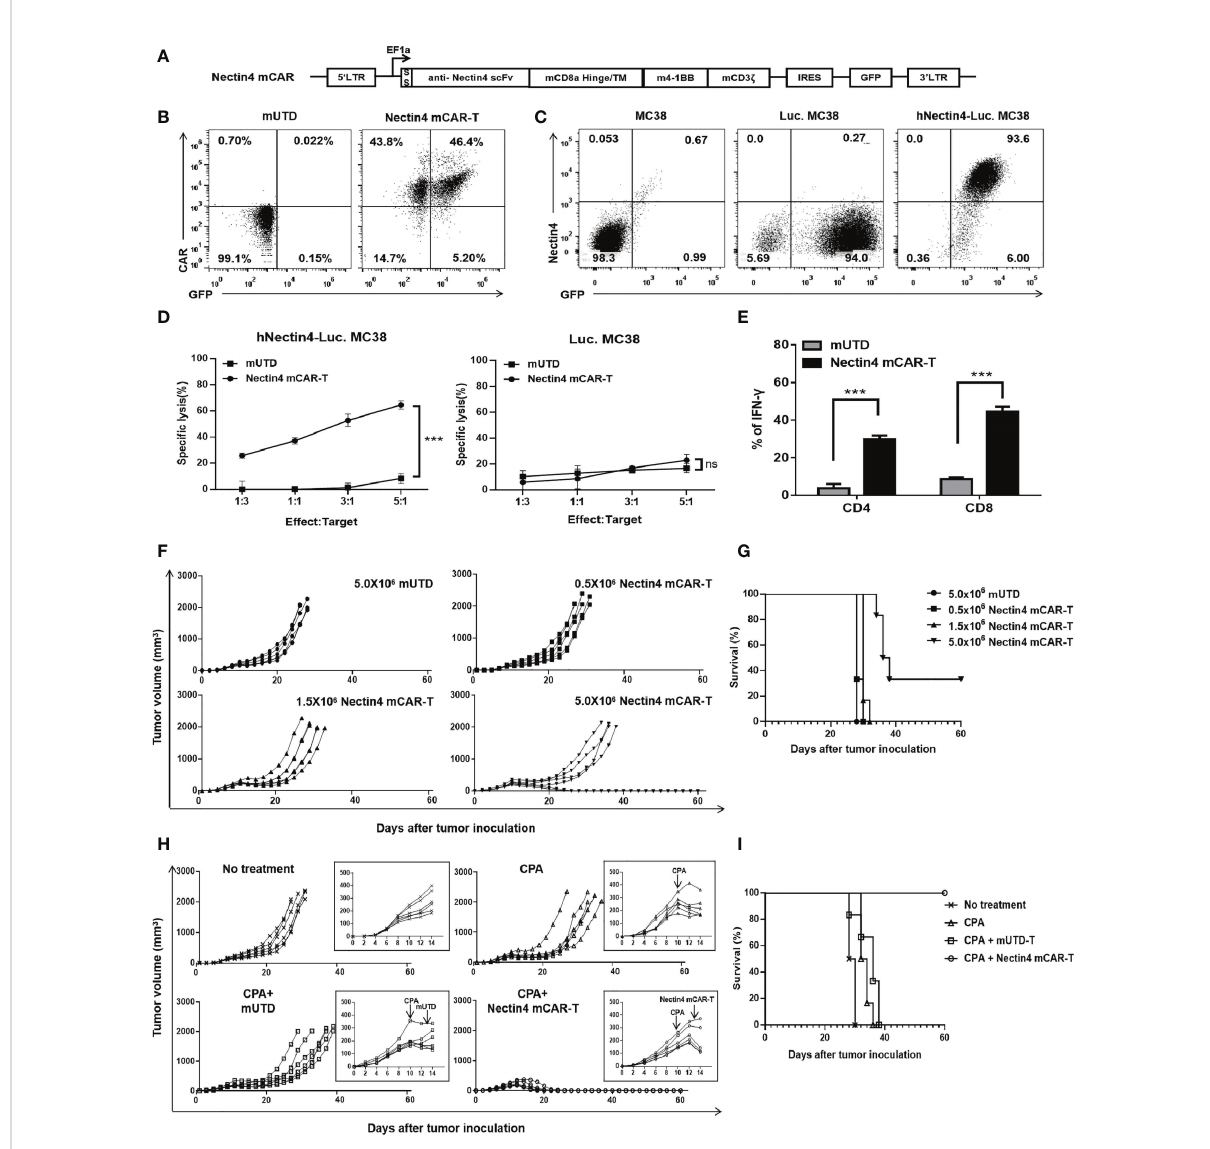
FIGURE 4 Therapeutic effect of Nectin4 mCAR-T cells on metastatic colorectal cancer in fully immune-competent mice. (A) The murine CAR construct was inserted upstream of an IRES-GFP marker in the MSCV retroviral plasmid pMIGR1. (B) mCAR expression of Nectin4 mCAR-T cells transfected with pMIGR1-mCAR-IRES-GFP retroviral particles. mUTD indicates the untransduced mouse T cells. (C) Nectin4 and GFP expression of Luc. MC38 cells and hNectin4-Luc. MC38 cells. (D) Quanti fi ed data on the speci fi c lytic levels of Nectin4 mCAR-T cells against Luc. MC38 or hNectin4-Luc. MC38 cells were assessed by luciferase bio-luminescence technique at different Effect/Target ratios in vitro . *** p < 0.001, t -test. (E) Secretion of IFN- g in CD4 + and CD8 + T subsets was assessed by fl ow cytometry after co-culture of Nectin4 mCAR-T cells or mUTD with hNectin4-Luc. MC38 cells for 12 h. *** p < 0.001, t -test. (F, G) C57BL/6 mice were s.c. inoculated with 1 × 10 6 hNectin4-Luc. MC38 cells on Day 0 and injected i.v. with 5.0 × 10 5 to 5.0 × 10 6 Nectin4 mCAR-T cells on Day 10. A total of 5.0 × 10 6 mUTD served as a negative control ( N =